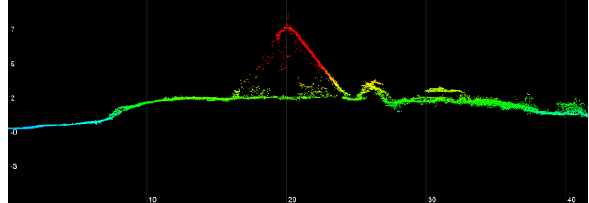
Figure 5. 2 m wide and 42 m long cross section through 3D- point cloud (from left to right) (beach – ornithological station - shed - shrubs)